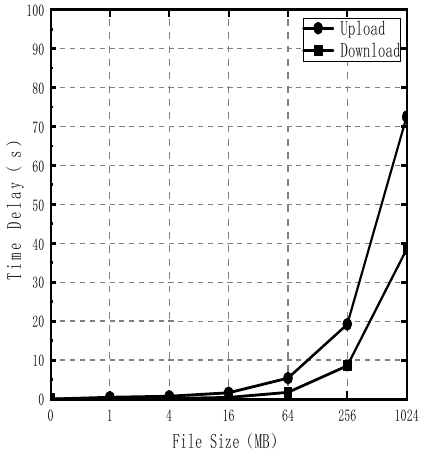
Figure 10. Cost of transmission.